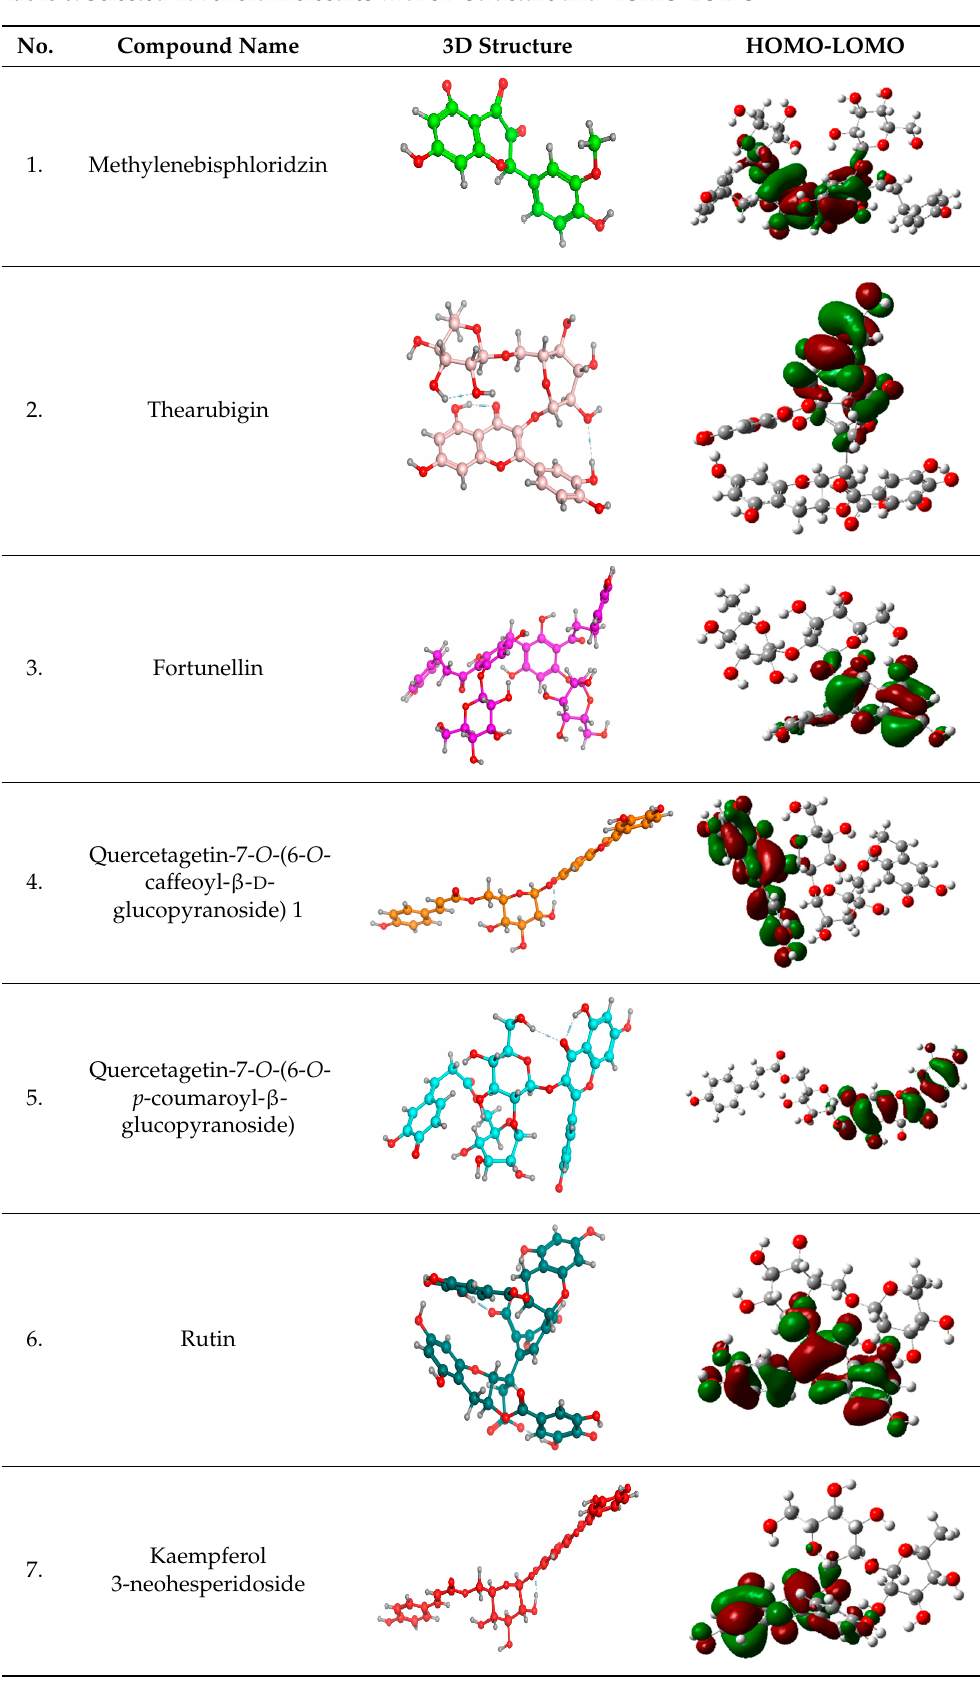
Table 6. Selected flavonoid molecules with 3D Structure and